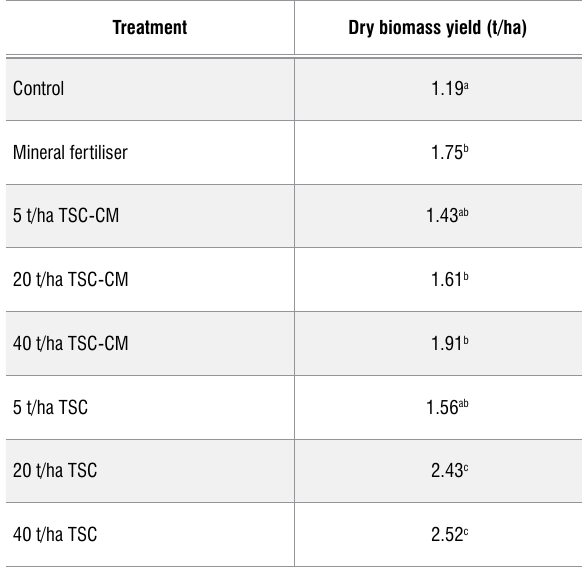
Means followed by the same lowercase alphabetical letters are not significantly different at p <0.05 according to Tukey’s honestly significant difference test. TSC, tobacco leaf scrap; CM, cattle manure; TSC-CM, tobacco leaf scrap and cattle manure